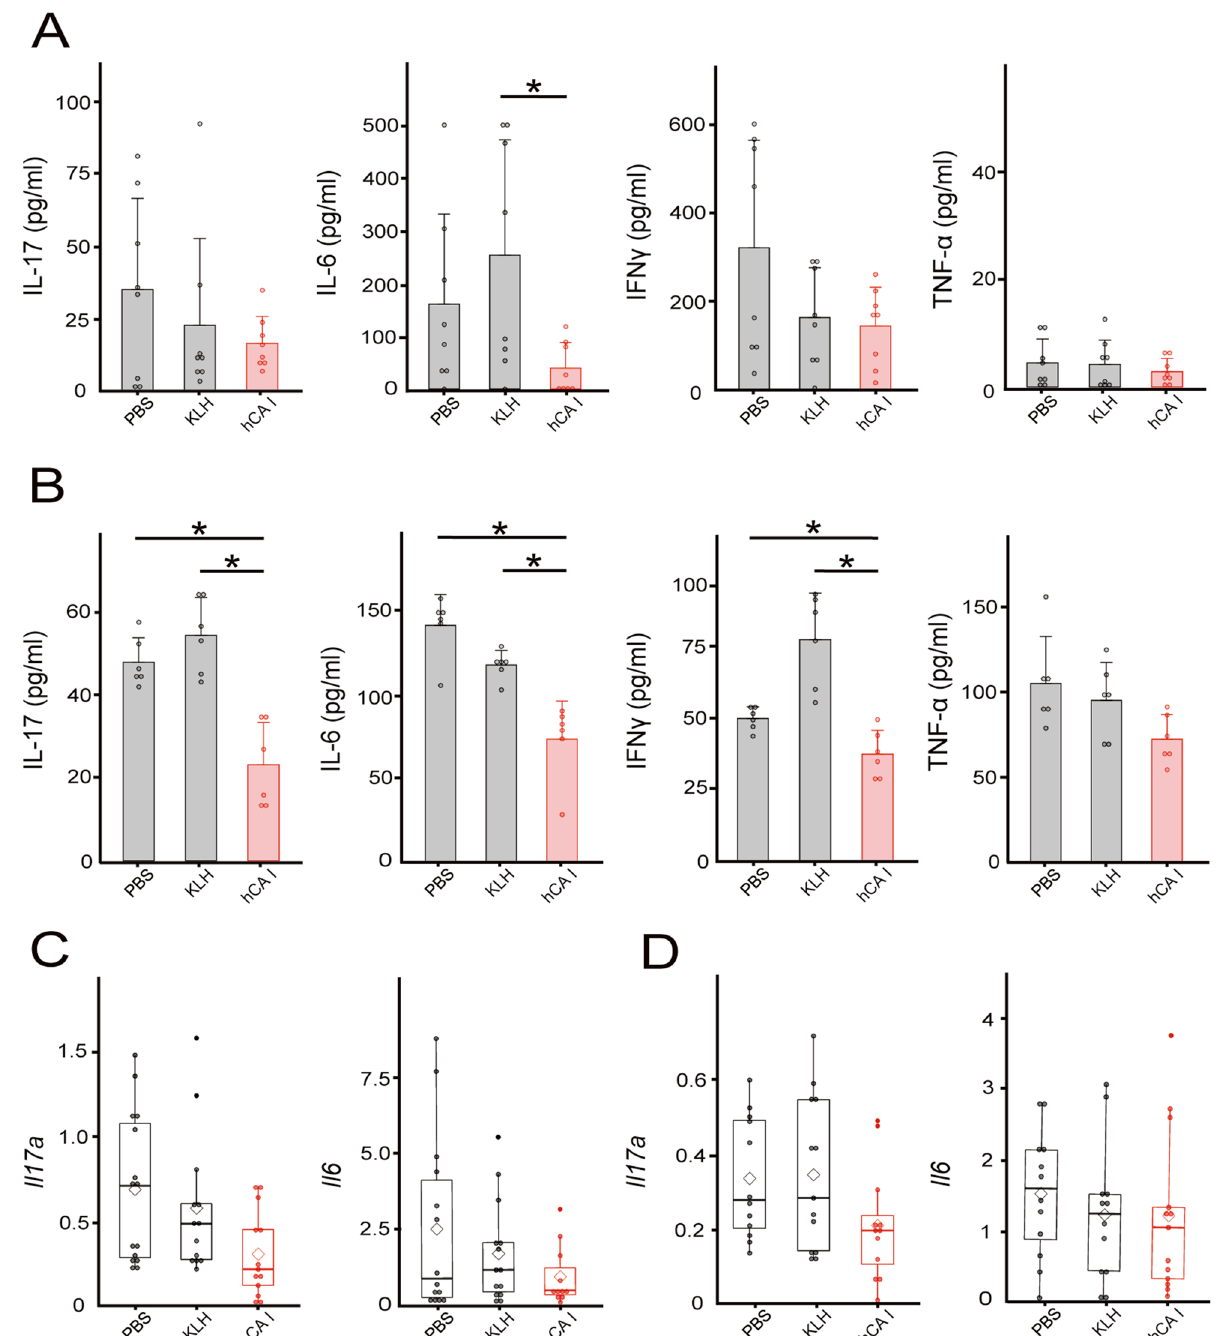
Figure 2. Treatment with orally administered hCA I suppressed inflammatory responses in the colon and MLNs in experimental colitis model mice. Four weeks after CD4 + CD25 − T cells and DCs were transferred, the colons and MLNs were collected. ( A ) the colons, cultured ex vivo for 72 h, were measured using ELISA; mean ± SD of 8 mice/group. ( B ) Secreted cytokine concentrations from MLN cells (1 × 10 6 ), cultured with PMA and ionomycin for 72 h, were measured using ELISA; mean ± SD of 6 mice/group; * P < 0.05. ( C ) Four weeks after CD4 + CD25 − T cells were transferred, transcription factor or cytokine mRNA expression levels in the colon were quantified using real-time RT-PCR; mean ± SD of 14–15 mice/group. ( D ) Transcription factor or cytokine mRNA expression levels in MLN cells were measured using real-time RT-PCR; white diamond indicates the mean, horizontal lines indicate the median, line indicate ± SD of 12–13 mice/group. * P <